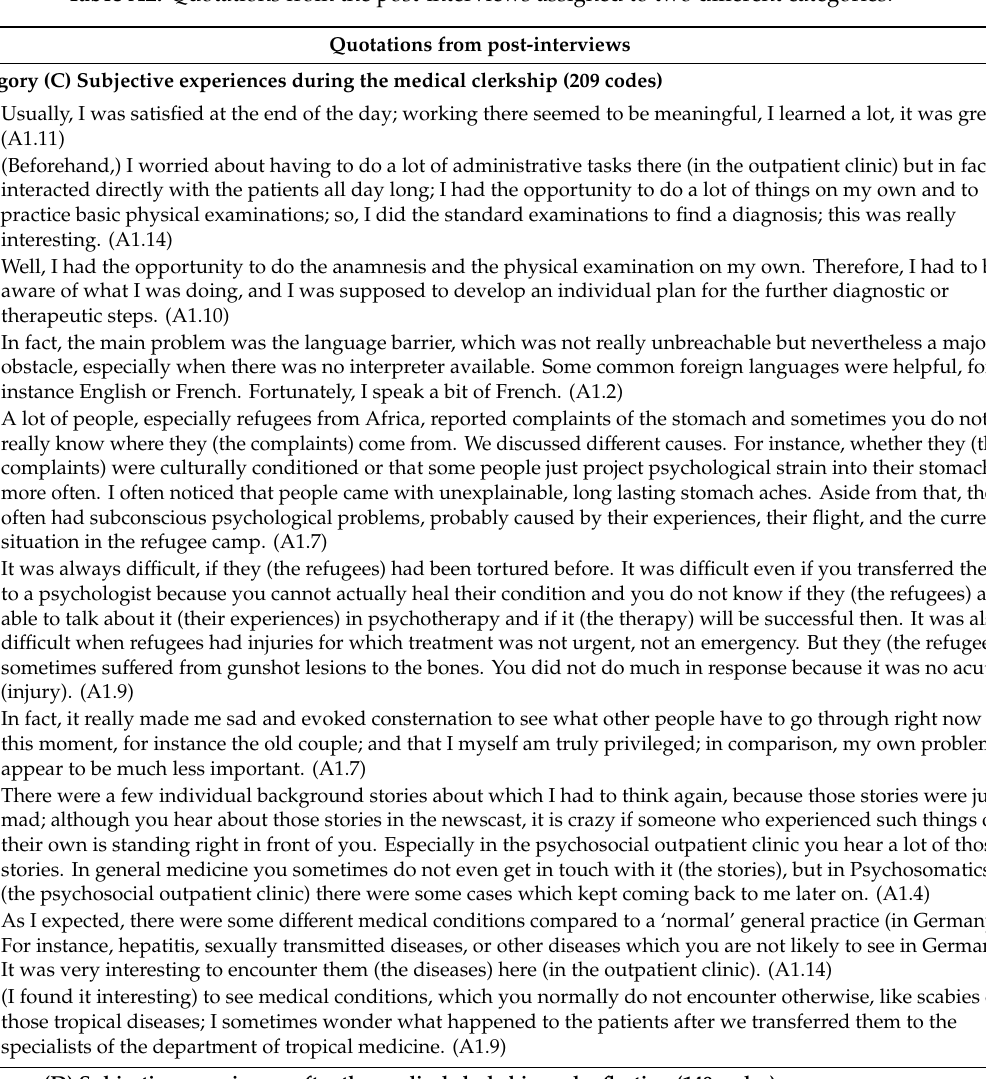
Table A2. Quotations from the post-interviews assigned to two di ff erent